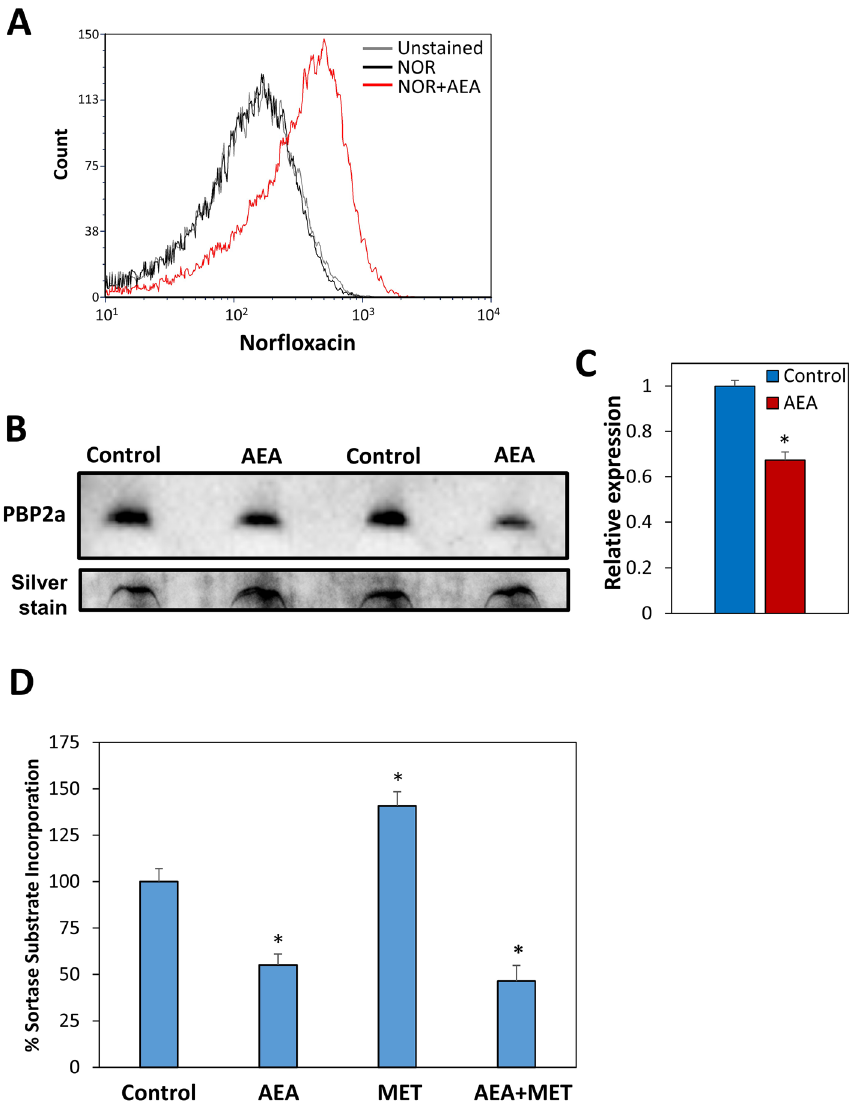
Figure 11. ( A ) AEA increases the intracellular level of norfloxacin. MDRSA CI-M was incubated with 25 µg/ ml Norfloxacin (NOR) in the absence or presence of 25 µg/ml AEA for 2 h at 37 °C. Then the norfloxacin was removed, and the amount of norfloxacin retained in the bacteria was measured after 3 h on flow cytometry. ( B ) PBP2a expression levels (upper panel) in crude membrane extracts of MDRSA CI-M treated with 50 µg/ml AEA for 2 h in comparison to control. Two different samples of control and AEA-treated bacteria are shown. Lower panel: Silver staining of the same samples in the polyacrylamide gel as loading control. ( C ) The relative PBP2a expression level in AEA-treated versus control MDRSA CI-M as measured from 4 different samples using the Photoshop software on the PBP2a panel shown in ( B ). ( D ) Inhibition of cell wall synthesis by AEA. MDRSA CI-M was incubated with 50 μg/ml AEA and/or 50 μg/ml methicillin (MET) for 2 h, and then incubated with Sortase Substrate I, FRET, for 2.5 h. At the end of incubation, the fluorescence intensity (Ex/Em = 340/490) of the washed bacteria was measured in a Tecan plate reader. * p <